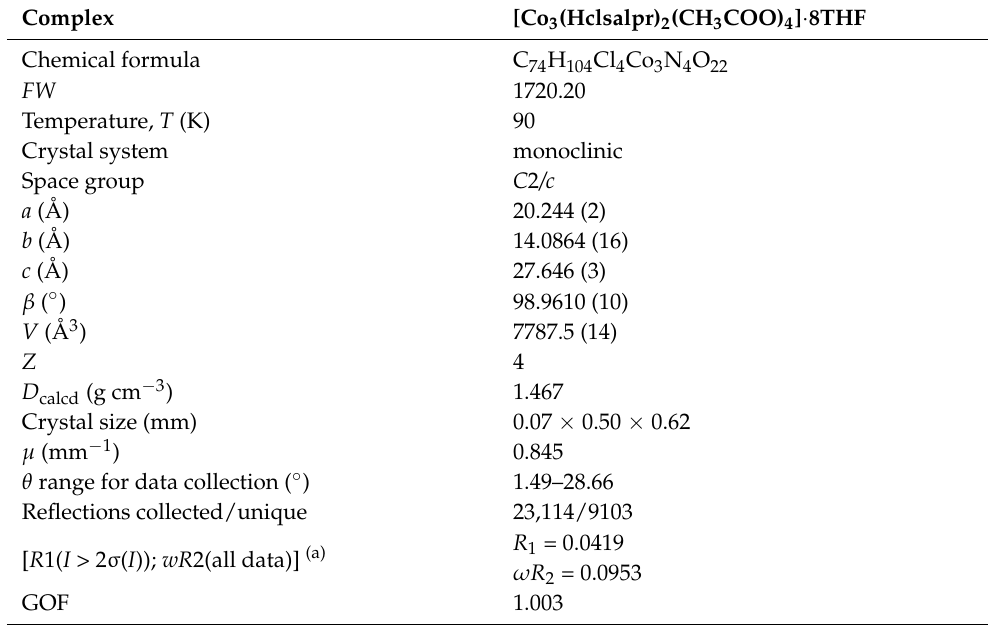
Table 1. Crystallographic data and structure refinement.